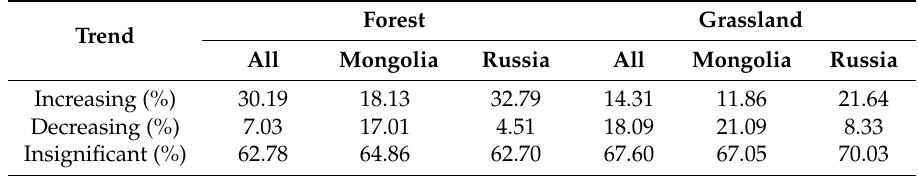
Table 1. Statistical results of the NDVI change trend for different vegetation types in the growing season. Trend